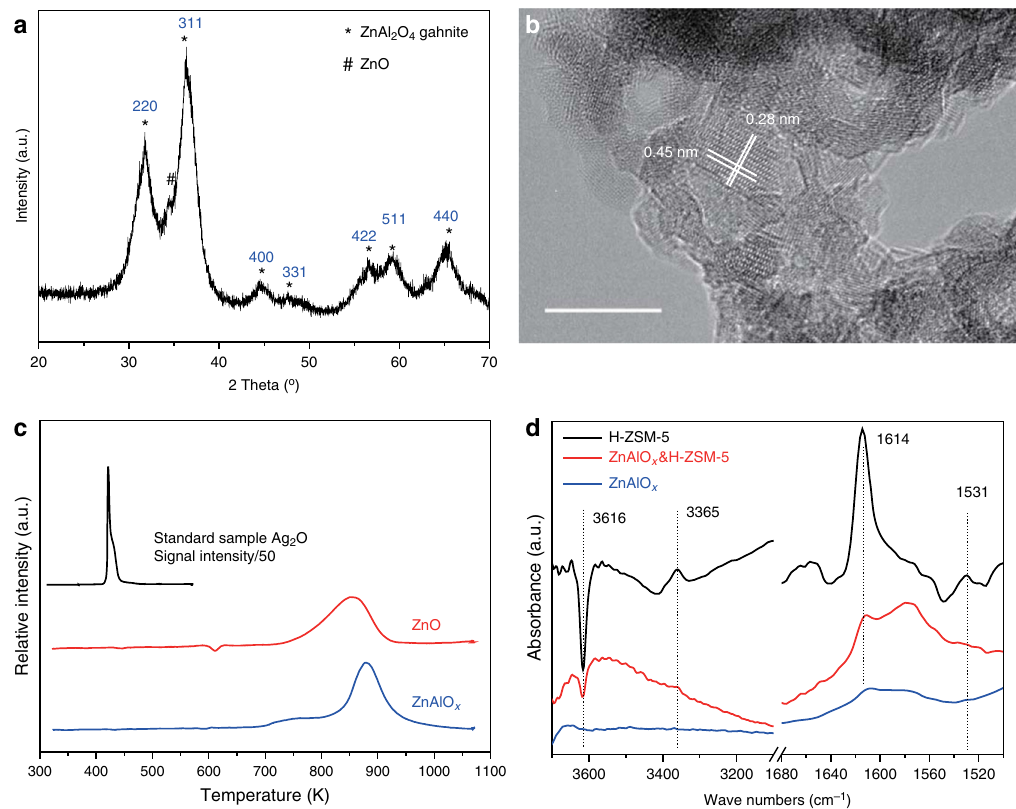
Fig. 4 Structural characterization of various catalysts. a X-ray diffraction patterns (XRD) of ZnAlO x . b High-resolution transmission electron microscopy (TEM) image of ZnAlO x . Scale bar: 10 nm. c H 2 -TPR pro fi les. The relative intensity was normalized by weight. The relative intensity of the standard sample Ag 2 O was divided by 50. d FTIR subtraction spectra relative to adsorption of DTBPy